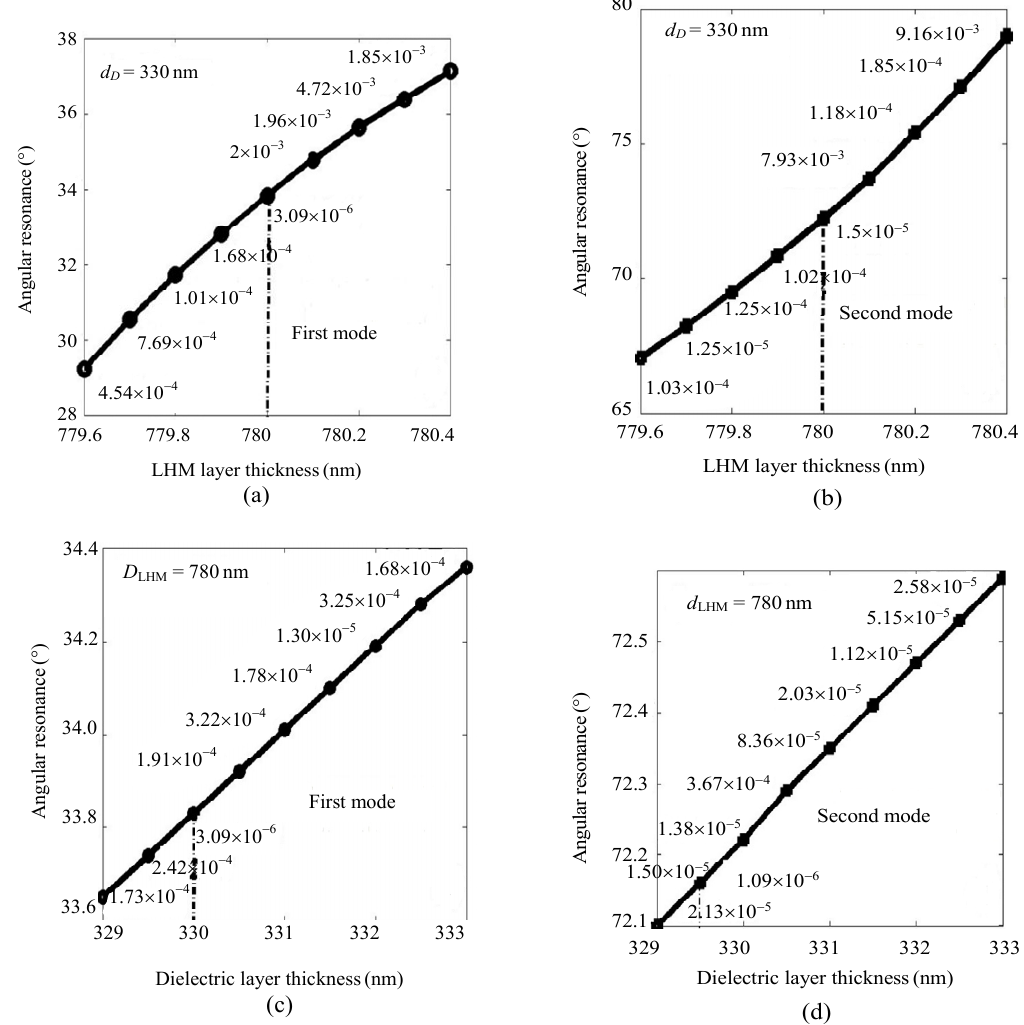
Fig. 5 Evolution in the SPR angle for: (a) the first-confined mode, (b) the second-confined mode displayed on the perpendicular enhancement factor, f under the change of the LHM thickness with a fixed dielectric layer, d D =330 nm, (c) first-confined mode,  and (d) second-confined mode displayed on the perpendicular enhancement factor, f thickness with a fixed, metamaterial layer, d LHM =780